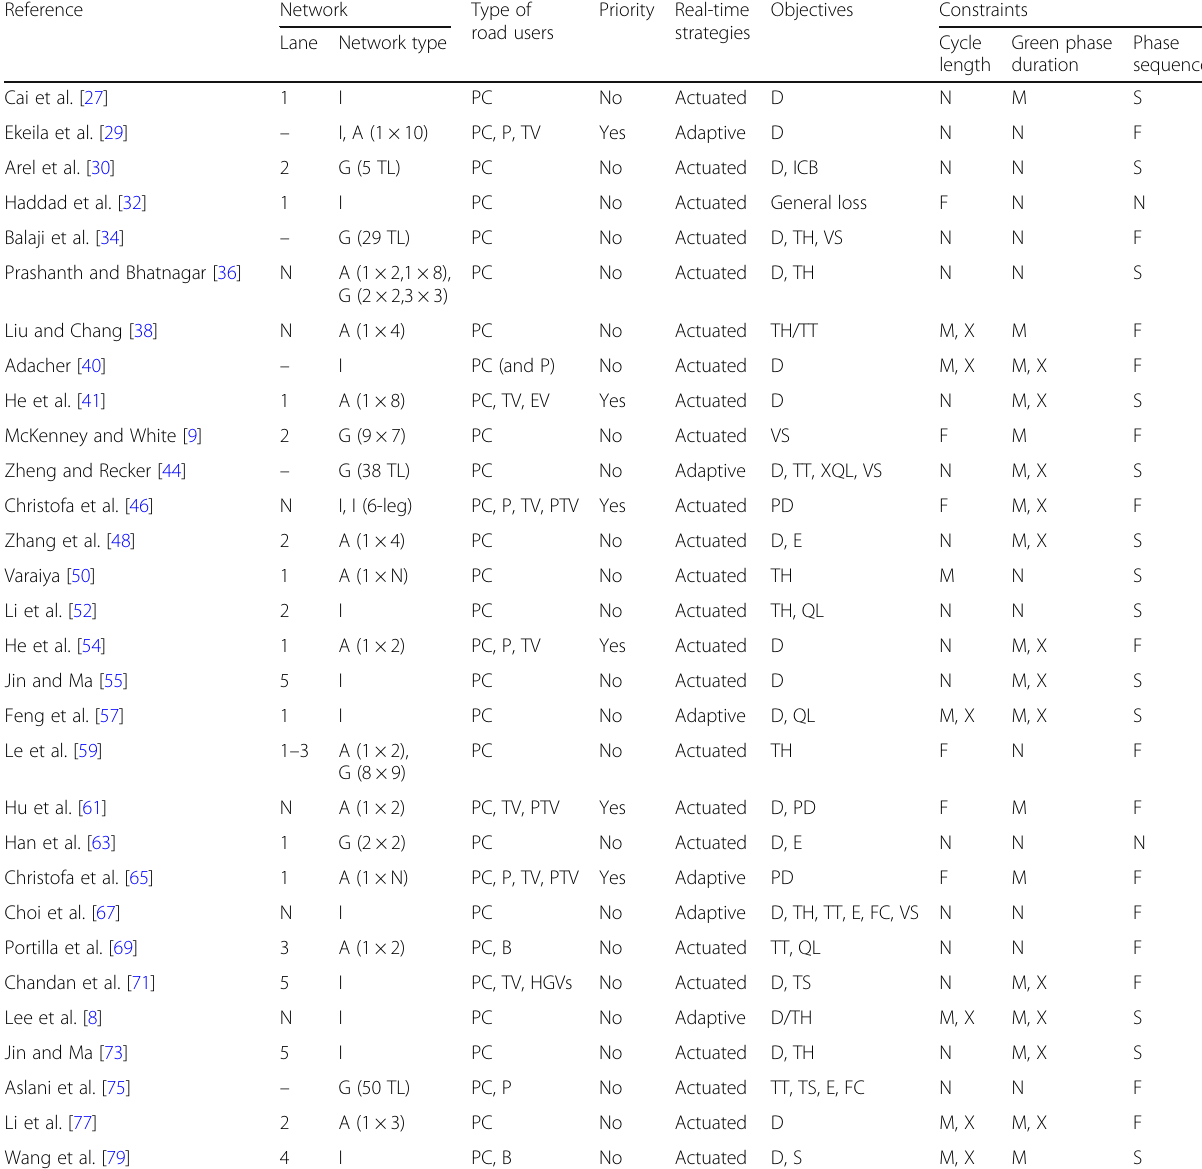
Table 3 Literature classification based on problem characteristics (Continued)